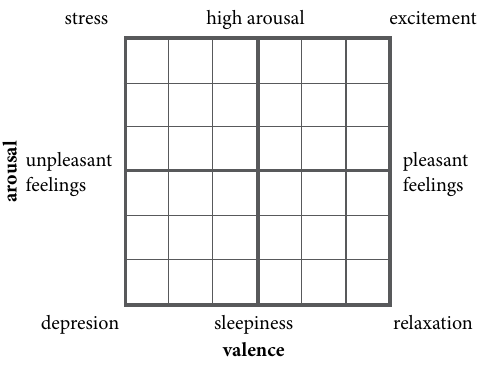
Fig. 4. An interpretation of the Affect Grid taken from (Mandryk, Atkins 2007) on having six levels of arousal and